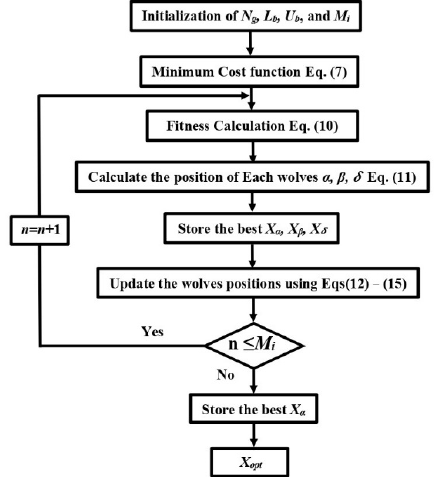
Figure 2. Flowchart of the proposed GWO algorithm.